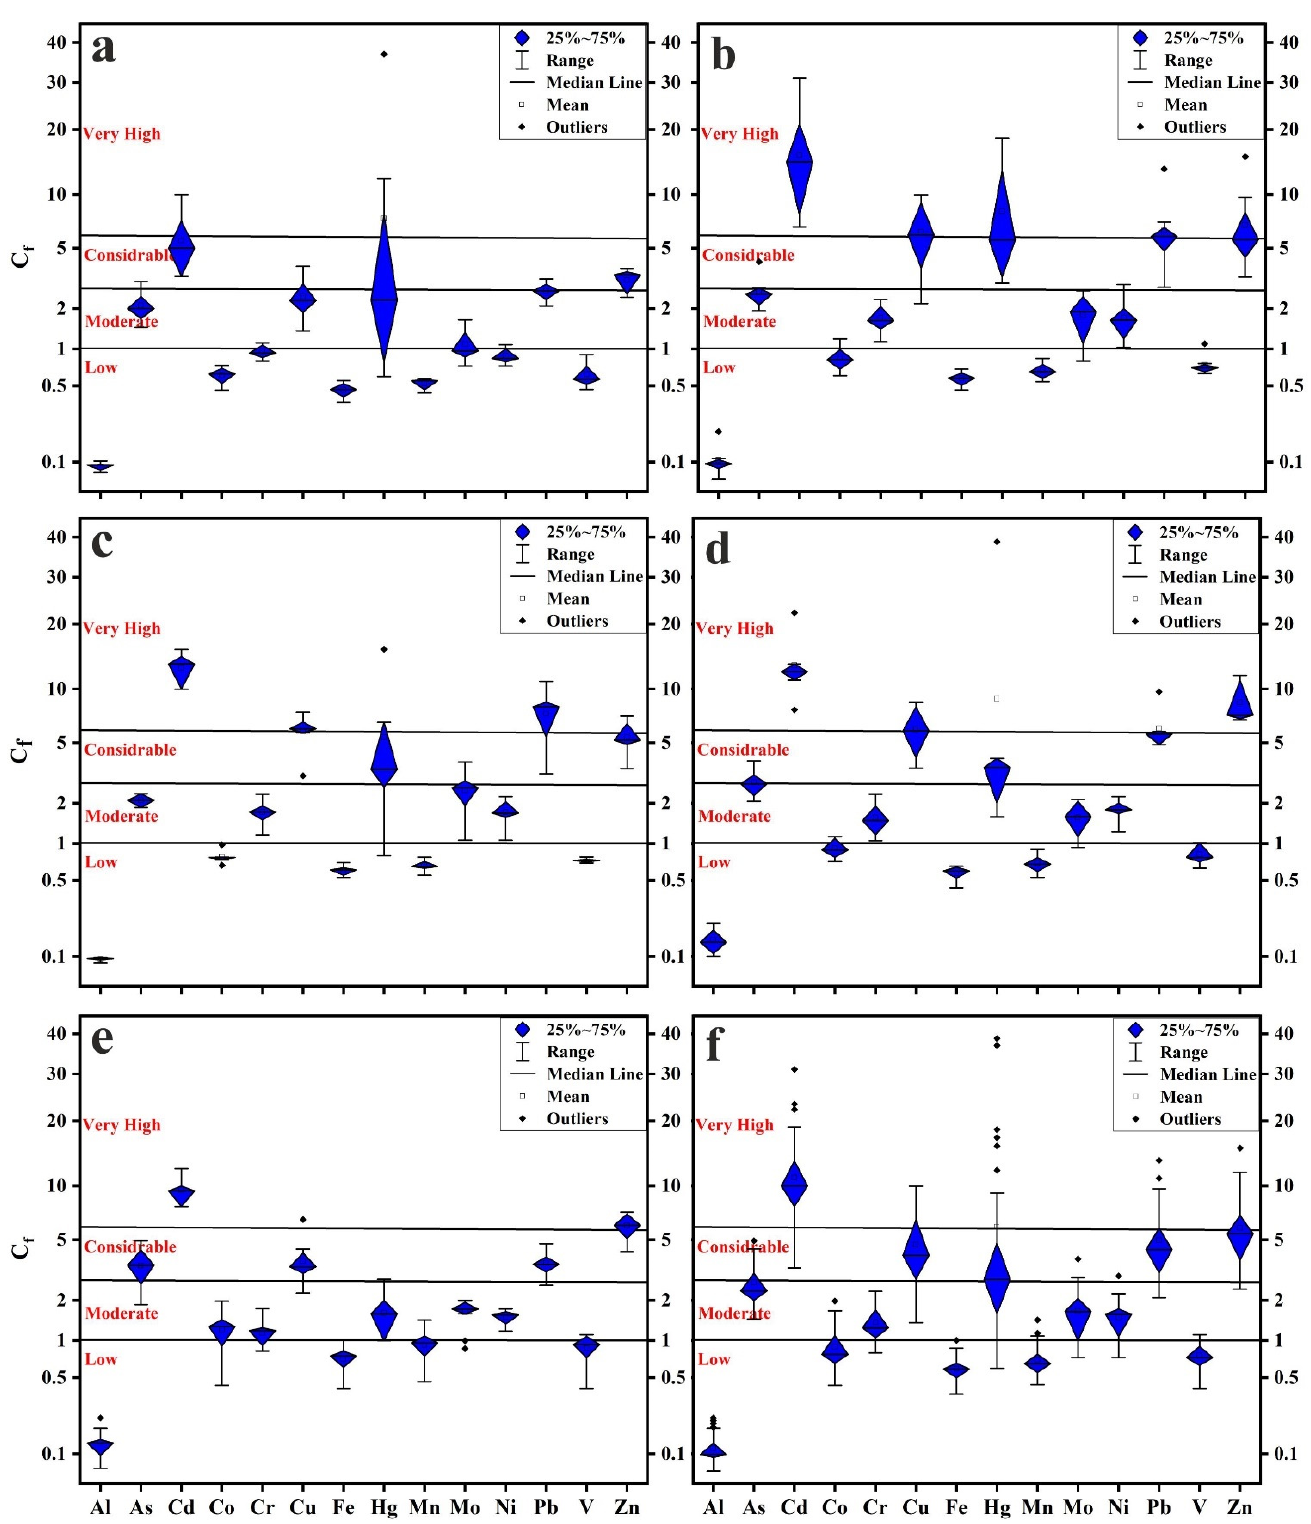
Figure 3. ( a ) Boxplots of C f values: New Cairo; ( b ) eastern region; ( c ) northern region; ( d ) western region; ( e ) southern region; ( f ) all samples.